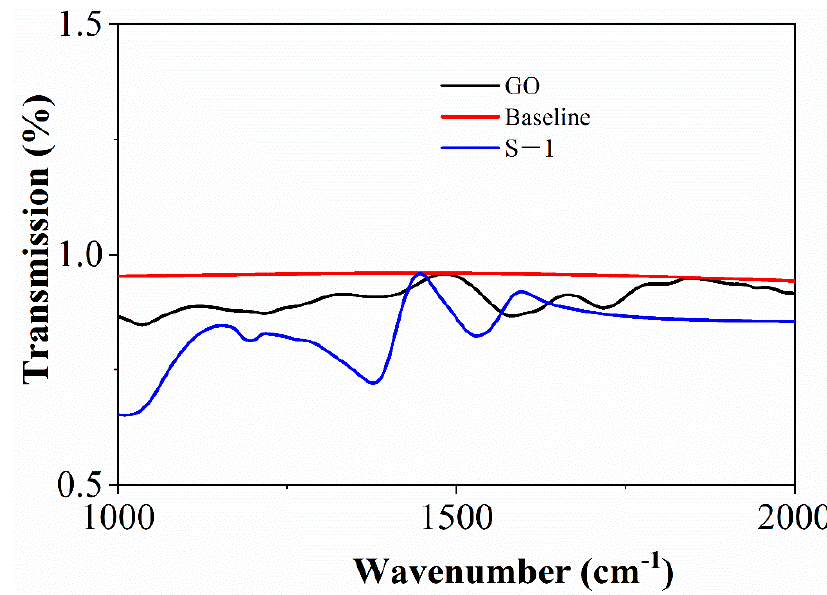
Figure 3. SEM images of ( a ) GO and ( b ) S-GO. ( c ) EDS spectrum and ( d ) element content of S-GO. Table 1. Element content of S-GO.